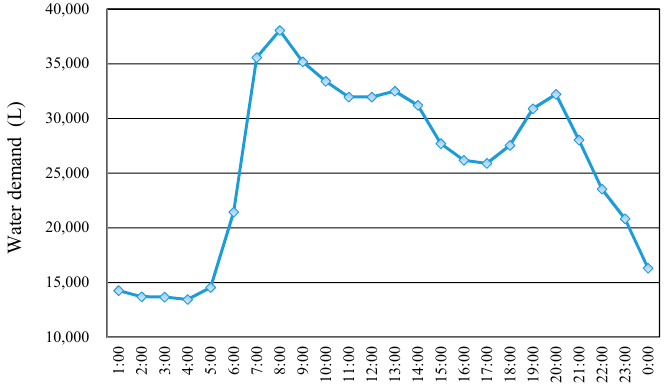
Figure 2. An example of time series data representing hourly water consumption in a day (L/h).